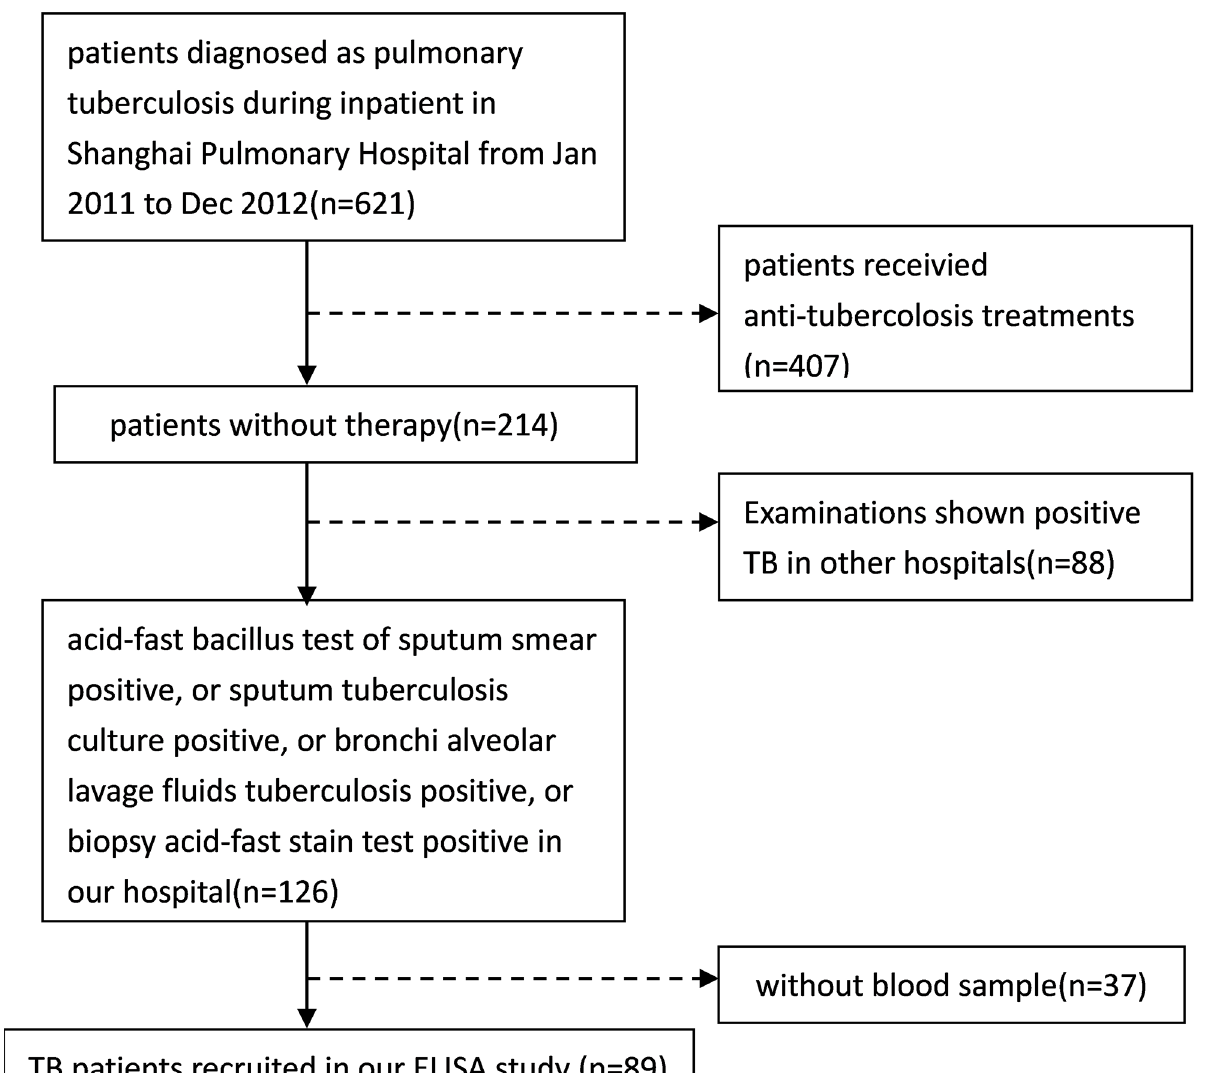
Fig 2. Procedure for recruiting TB